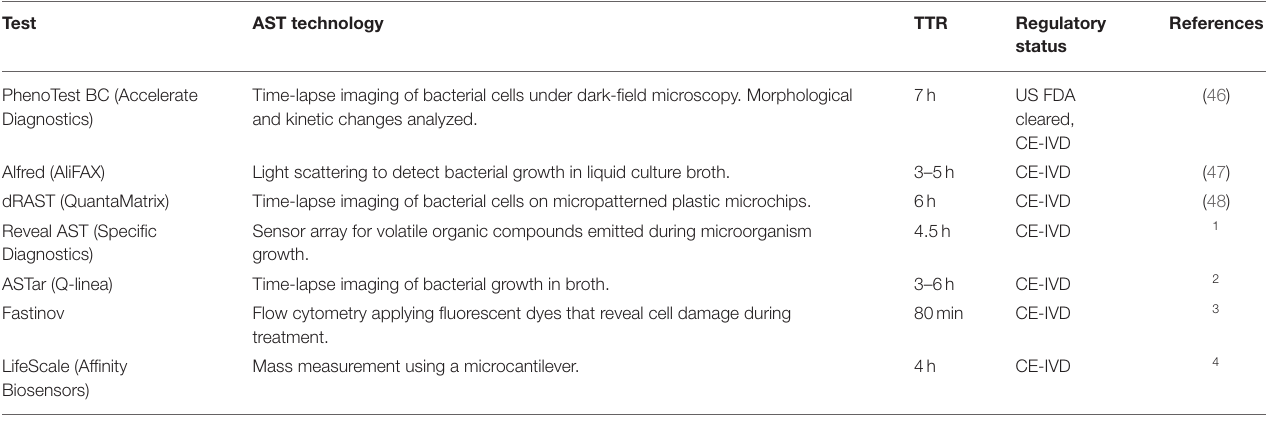
TABLE 1 | Select rapid phenotypic AST methods that are approved for testing positive blood cultures. Test AST